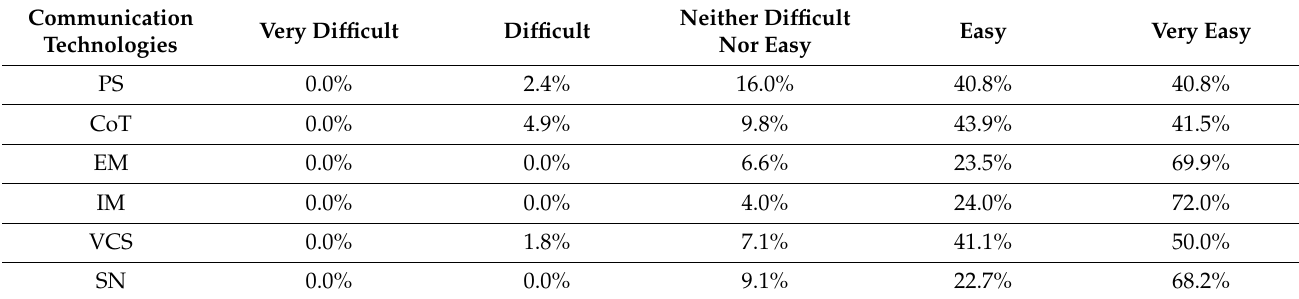
Table 11. Ease of use communication technologies by